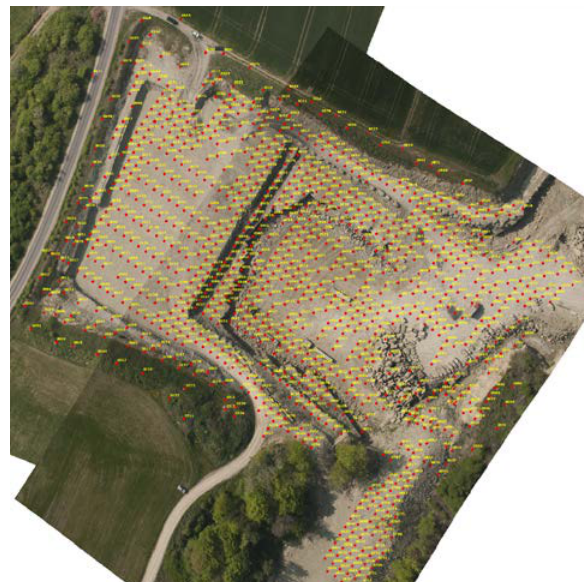
Figure 2. Quarry serving as test field. Red dots representing the location of 1042